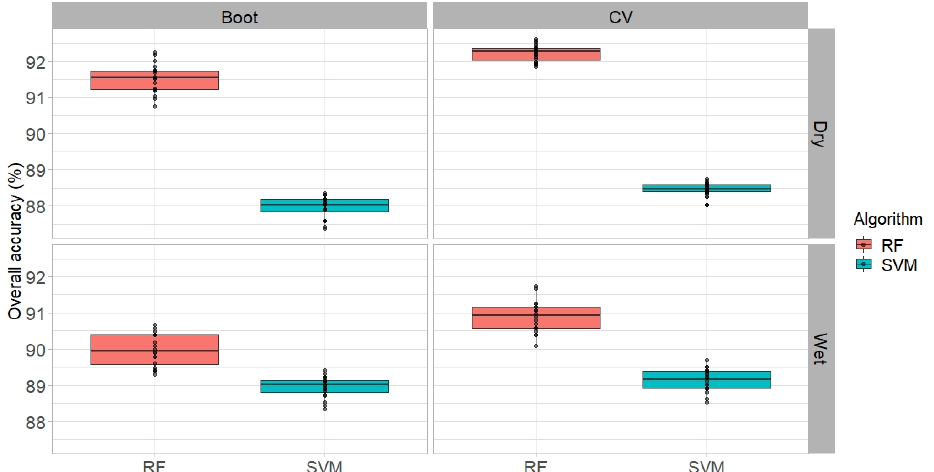
Figure 5. Accuracy assessment based on overall accuracy (OA) by the classification algorithm